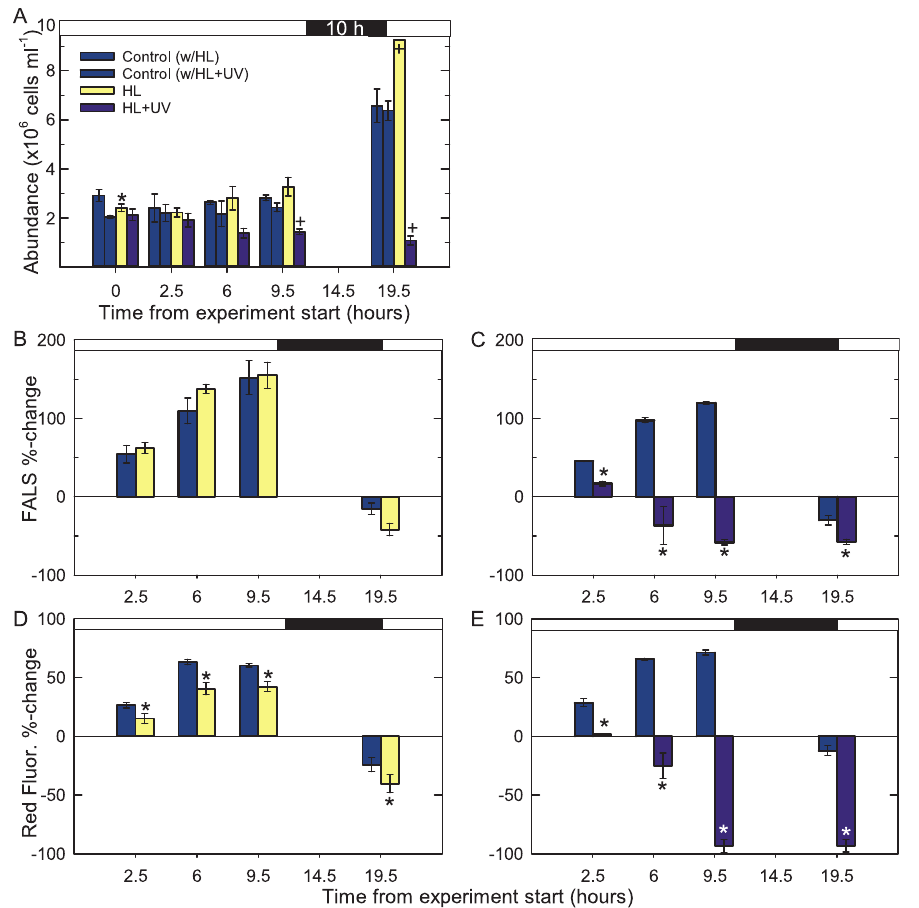
Fig 3. Micromonas commoda abundance and cellular characteristics in long-exposure light shift experiments. Cells were in acclimated, mid-exponential growth at 100 μ mol photonsm -2 s -1 on a 14:10 L:D cycle for (cid:21) 9 generationsprior to the shift to 625 ± 35 (SD) μ mol photonsm -2 s -1 at the first time point of the experiment, T 0 , which occurred 4.5 h after lights-on. (A) Cell abundance, with light (white) and dark (black) periods indicatedby the horizontalbar along the top of graph, treatments and controls are colored as indicatedon graph. (B-C) Percent changein bead normalized mean FALS cell -1 from the T 0 value after a shift to (B) HL and (C) HL+UV treatments, as well as the respective controls. Vertical bar coloring is as indicatedin (A). (D-E) Percent changein bead normalized mean red fluorescence cell -1 in the (D) HL and (E) HL+UV treatments and their respectivecontrols. Cells at T 0 were 4.5 h into the light period, where red fluorescence and FALS is higherthan at lights-on(see Fig 2), hence the negativepercent changes at T 19.5 (the point of lights-on/the end of the dark period) are expected. Data representthe averageof biological triplicates and error bars represent the standarddeviation. P -values < 0.05 ( * ) and < 0.001(+, Fig 3A only) are indicatedfor significantdifferences from controls at the same time point (HL vs. control 1, HL+UV vs. control